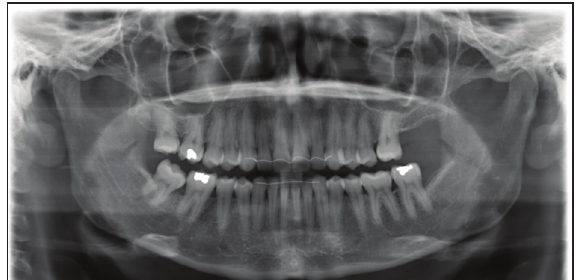
Figure 12. Panoramic radiograph immediately after debonding and completion of active orthodontic treatment.